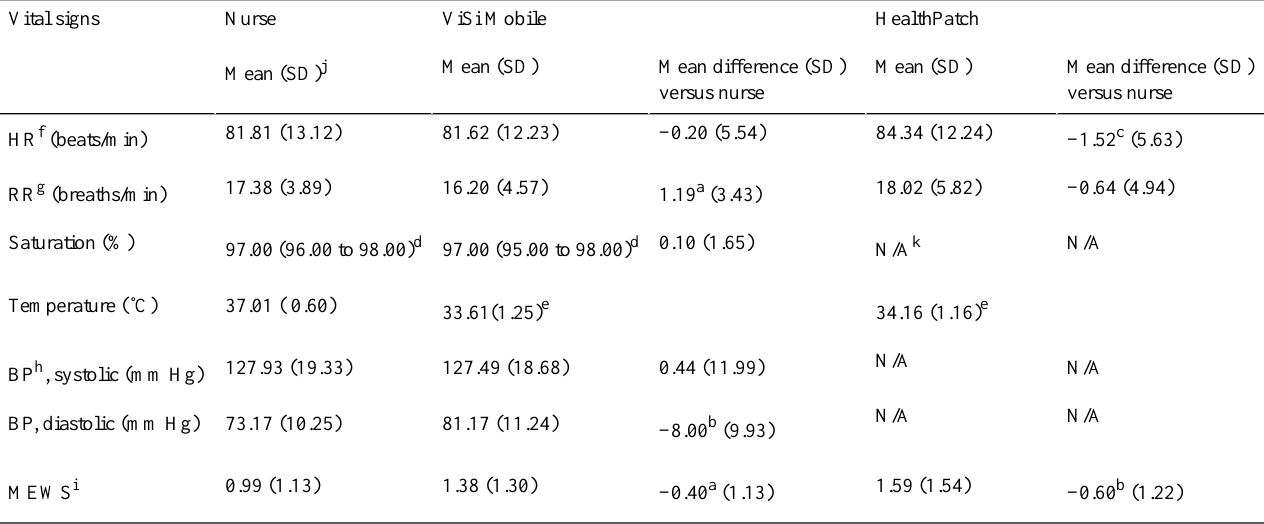
Table 2. ViSi Mobile and HealthPatch data in comparison with corresponding nurse